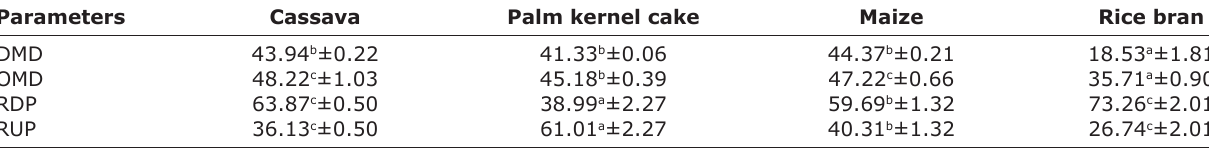
, total VFA, and partial VFA concentration of forages. 3